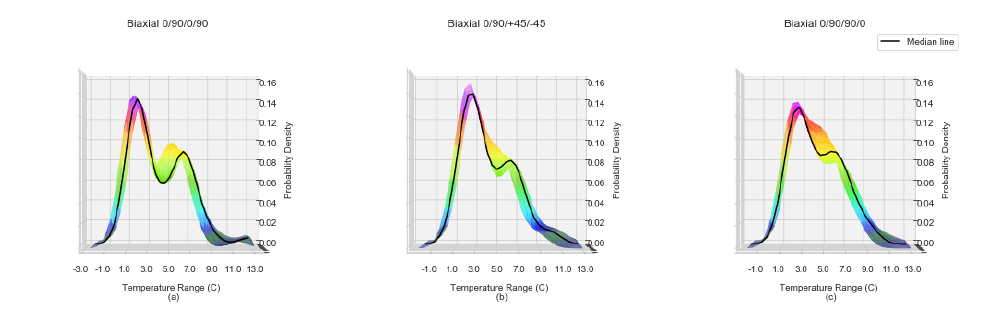
Figure 3. Kernel density estimates with median line for Biaxial laminate samples for temperature changes ranges − 3 ◦ to 12 ◦ for the time period 150 to 300 s ( a ) Biaxial 0/90/0/90, non symmetrical and balanced, ( b ) Biaxial 0/90/+45/ − 45, non symmetrical and unbalanced, ( c ) Biaxial 0/90/90/0, symmetrical and balanced.